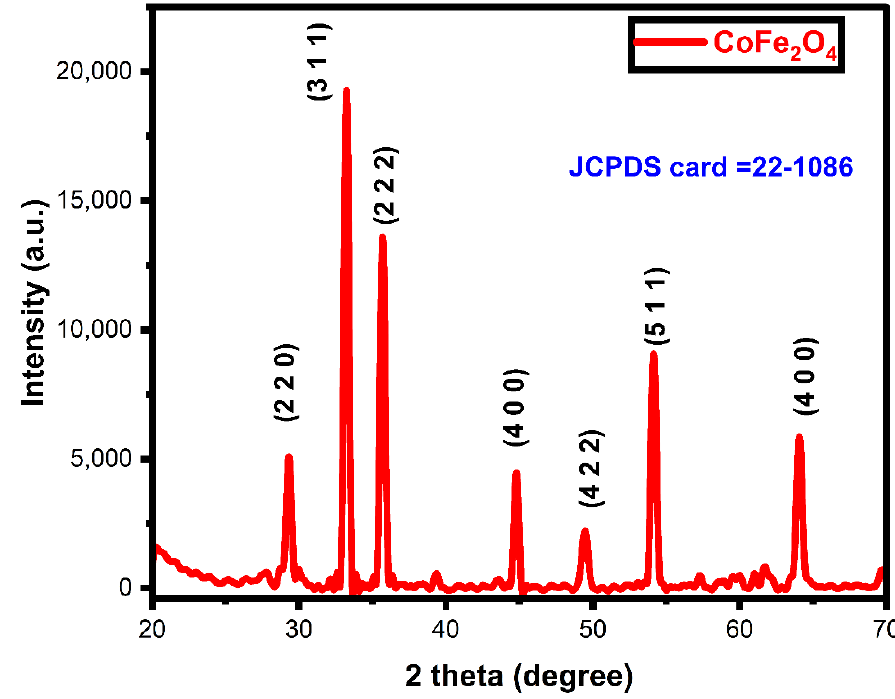
Figure 1. XRD pattern of biosynthesized CoFe 2 O 4 nanoparticles.